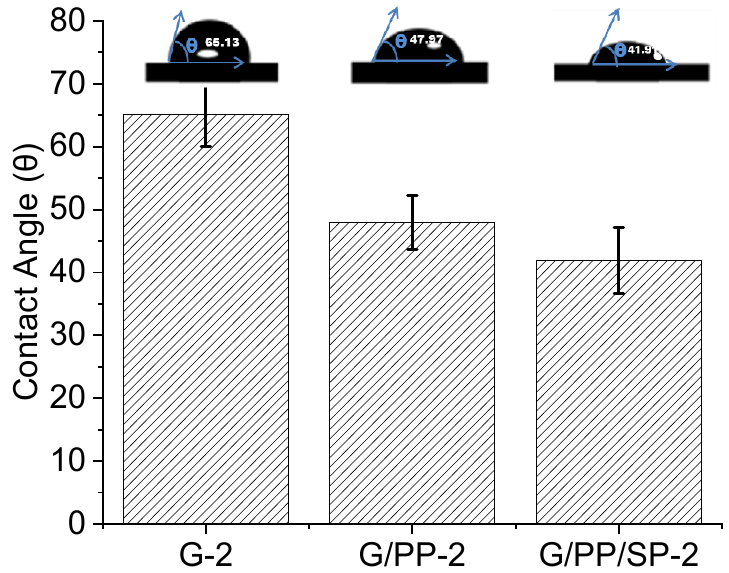
Figure 5. Hydrophilic nature of the edible film, showing water droplet shape as well as measured